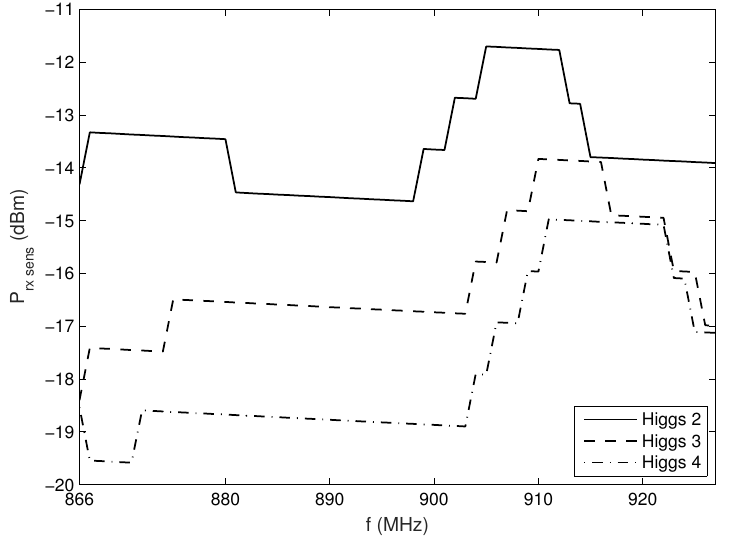
Figure 6. Measured sensitivity levels for Higgs 2, Higgs 3, and Higgs 4.